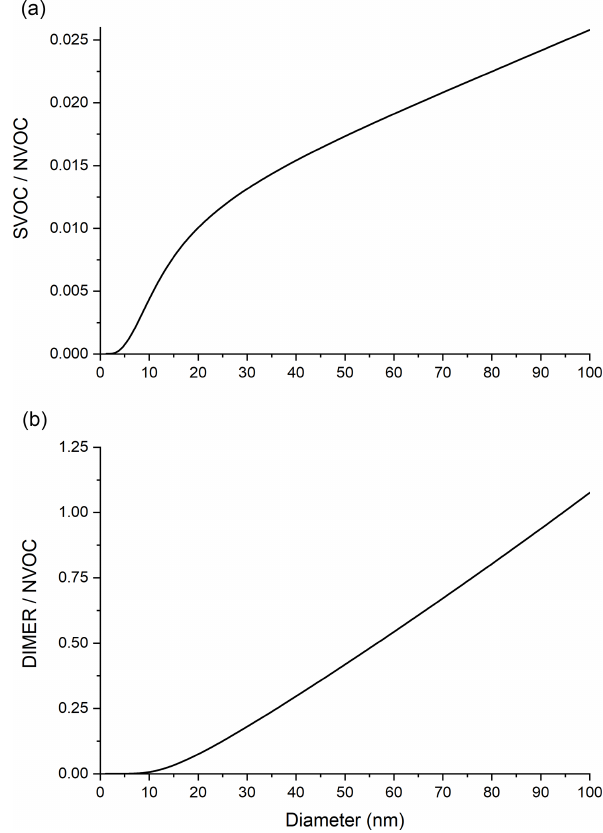
Figure 4. Mass ratio vs. particle diameter for (a) SVOC to NVOC and (b) DIMER to NVOC, under conditions where both partitioning and particle-phase chemistry (SVOC–SVOC dimer formation) are